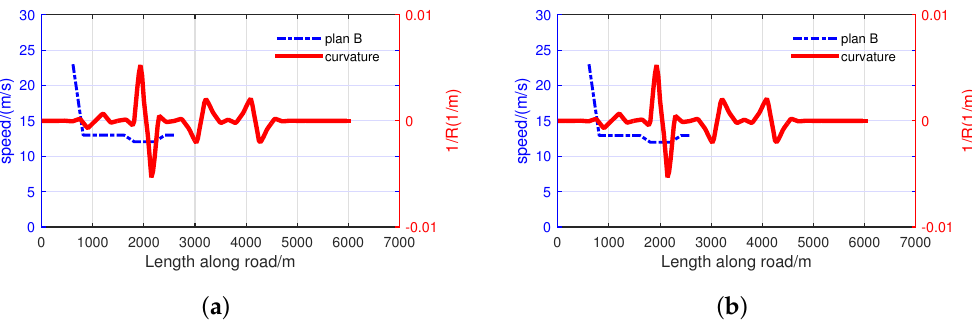
Figure 32. Speed Plan B: ( a ) Controller A + ISPFCE and ( b ) Controller B + ISPFCE.